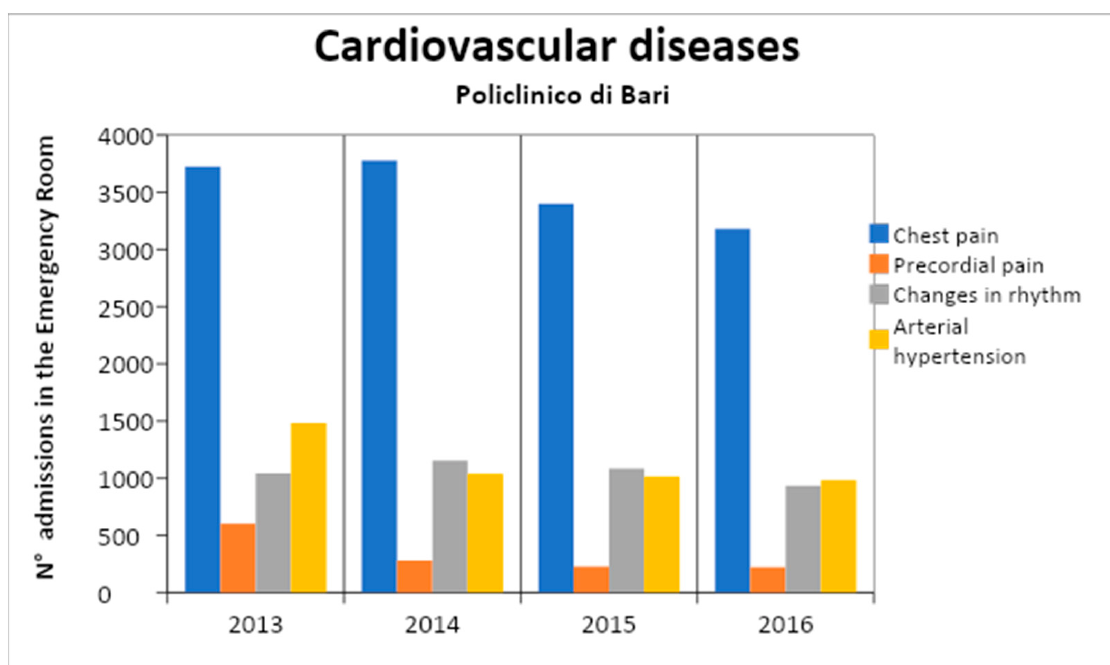
Figure 3. Annual admissions for CVD.